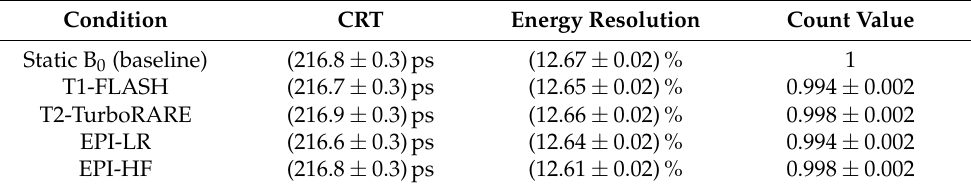
Table 3. CRT, energy resolution and count value (observed coincidences normalized by expected counts, relative to baseline) in low decay rate (365kBq) PET data acquisition during simultaneous MRI operation.